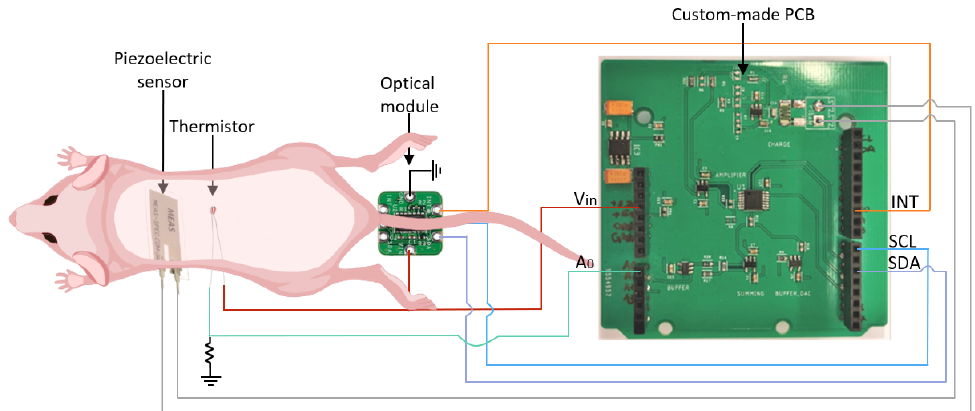
Figure 3. Schematic of BALB/c nude mouse positioning in the system and the sensor’s connections to the custom-made PCB. The piezoelectric sensor is under the mouse’s thoracic cage, the thermistor is under the belly, and the optical module is positioned below the tail’s basis. Vin—input voltage for the optical module and thermistor; A 0 —ADC channel for the thermistor data; INT—Active-Low Interrupt (Open-Drain) of the optical module; SCL—optical module I2C clock input; SDA—optical module I2C